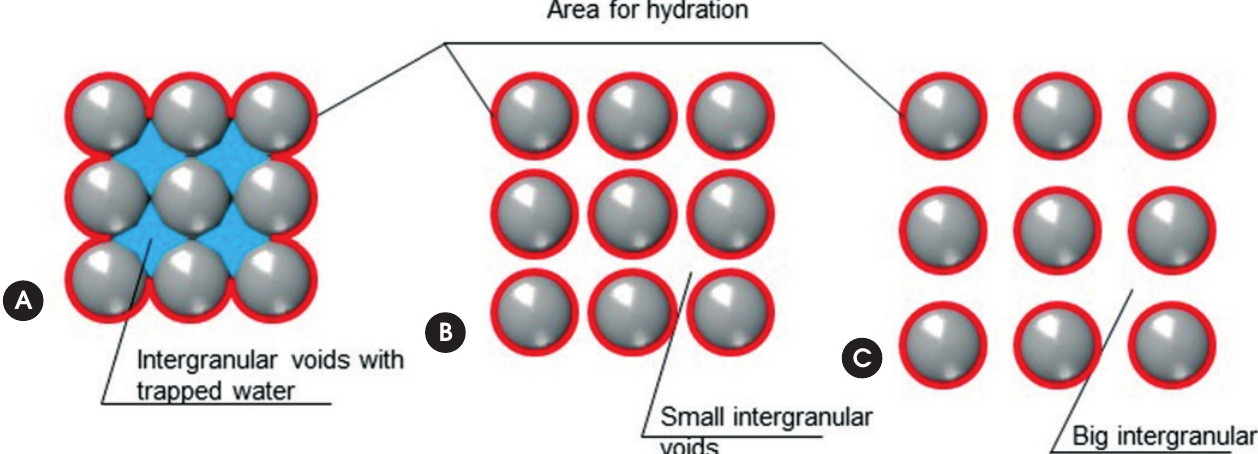
a) Non-dispersed particles, causing water entrapping and flow obstruction; (b) dispersed particles; (c) dispersed particles with higher distance